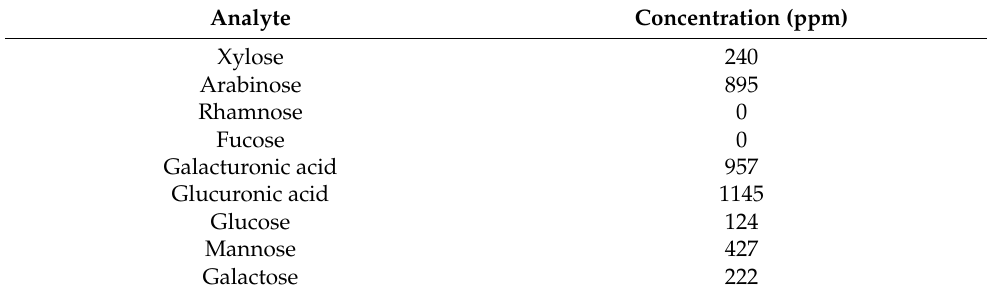
Figure 6. GC-MS chromatogram in SIM mode of the preparation layer of the archaeological sample subjected to the SPE column clean up under optimum elution conditions (experiment C). The peaks in the chromatogram with no assignment were not identified. I.S.: internal standard. Table 4. Concentrations (ppm) of monosaccharides and uronic acids determined in a sample collected from the preparation layer of an ancient mural painting (3.7